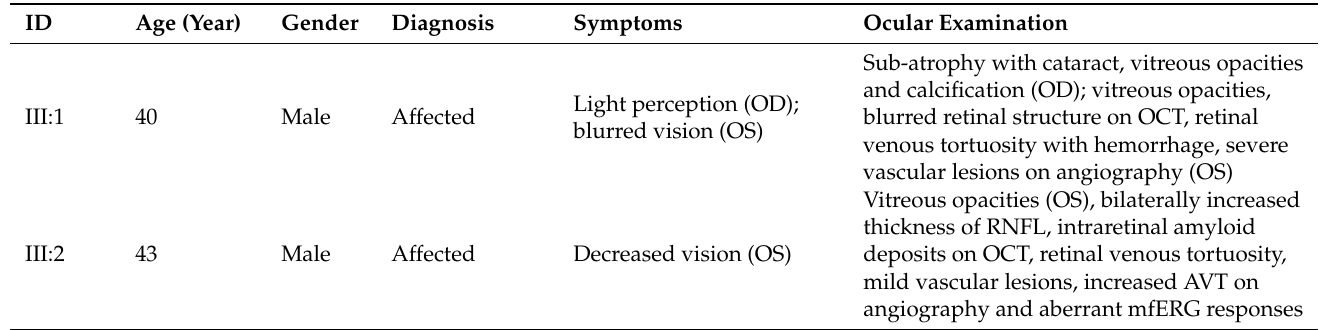
Table 1. Summary of the clinical information of the family members included in the